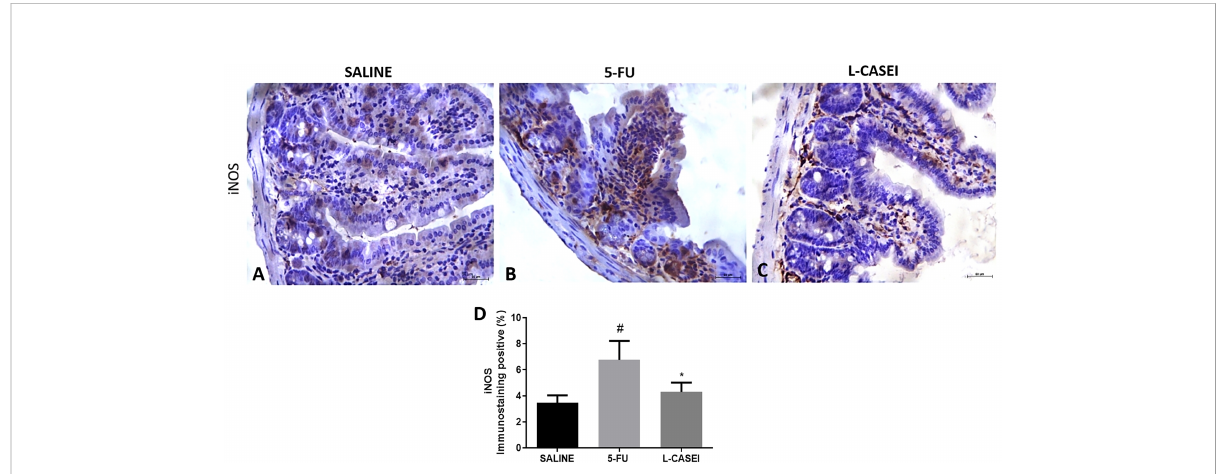
FIGURE 4 Representing examples of iNOS immunostaining: Control (Saline; A ), 5-FU (B) ; L. casei (LC; C ) and percentage of iNOS immunolabeled cells (D) . Values were expressed as mean ± SEM. For statistical analysis, one-way ANOVA was used followed by Tukey's test, where # p < 0.05 vs. control group, *p < 0.05 vs. 5-FU group. Magni fi cation